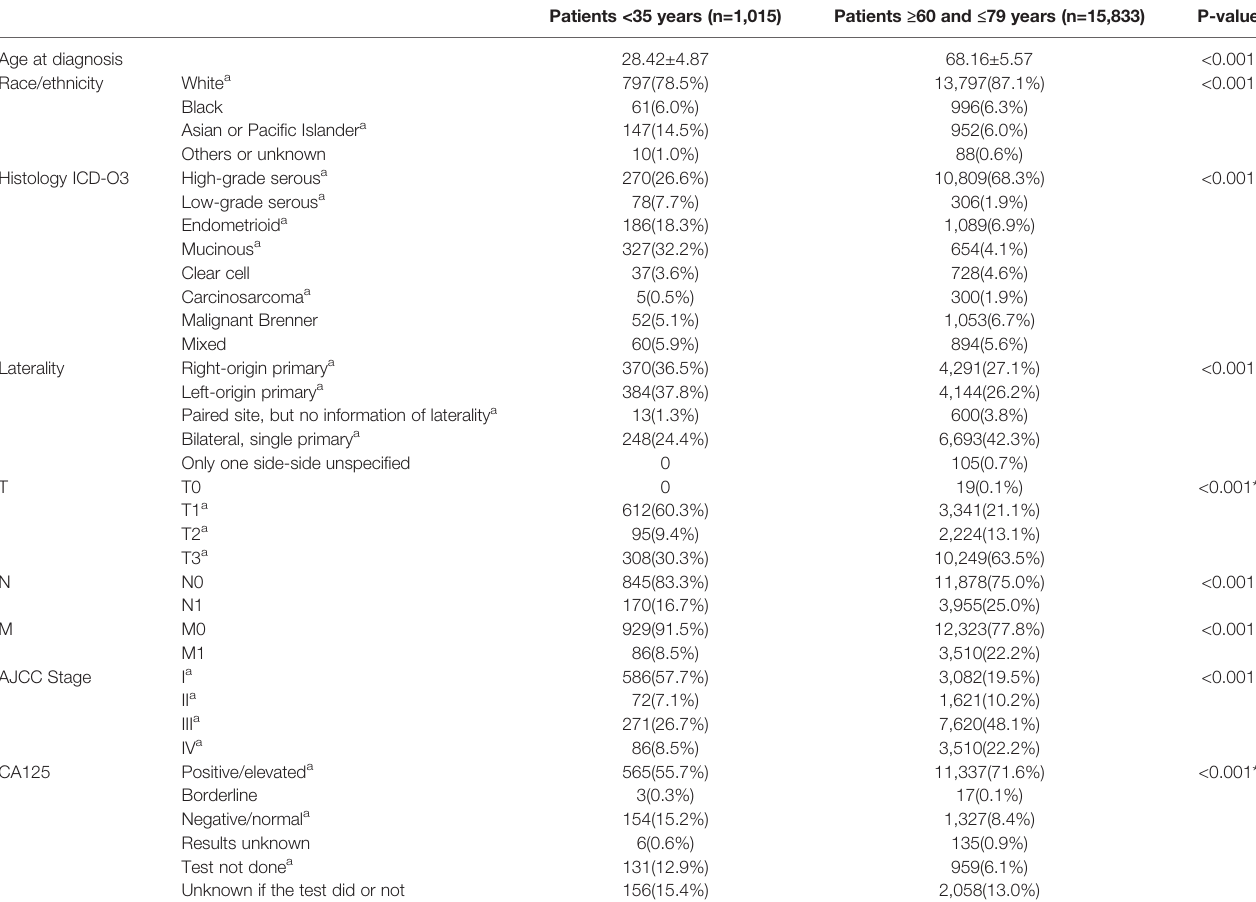
TABLE 1 | Clinicopathological characteristics of young and old patients with epithelial ovarian cancer in 2004 – 2015, SEER 18